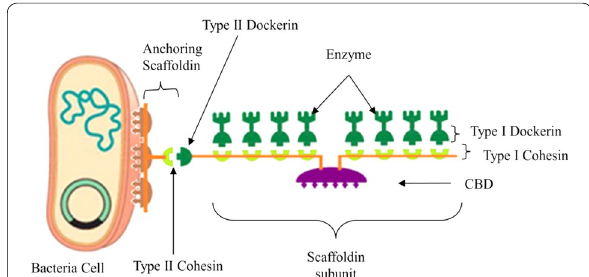
Fig. 4 Schematic architecture of bacterial cellulosome. The desired enzymes are assembled onto a suitable peptide with the help of cohesin–dockerin arrangements. The anchoring scaffoldin ensures the surface attachment of the cellulosome onto the bacteria surface [The figure was modified from Juturu and Wu